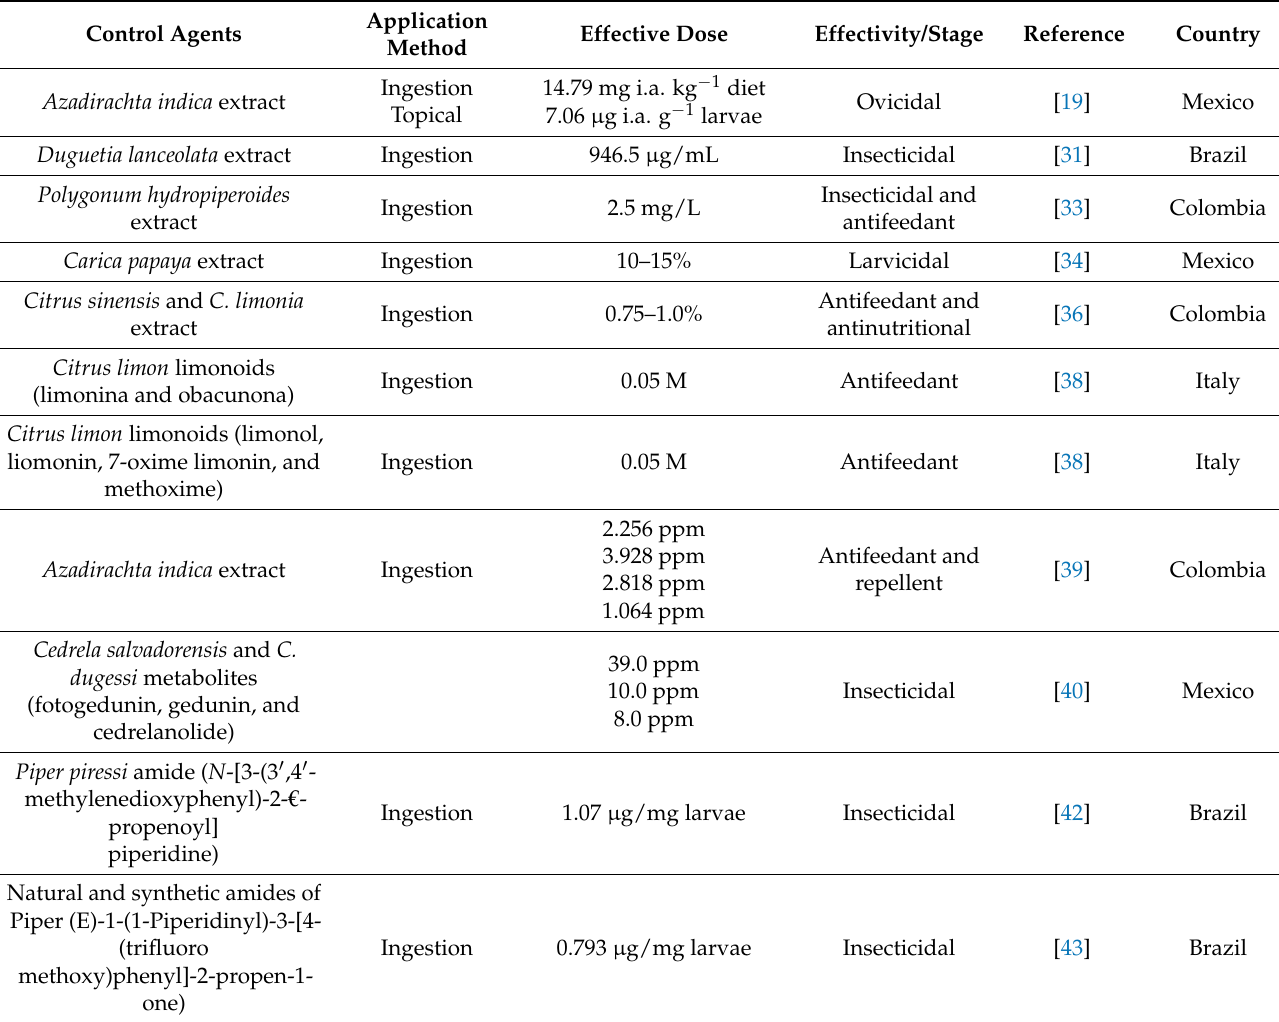
Figure 14. Structure of the active 2,4,5-trimethoxystyrene metabolite from Duguetia lanceolata. The insecticidal activity of common pesticidal plants was recently evaluated on a population of second instar larvae of S. frugiperda from Malawi, Africa. Ten extracts of the plants Azadirachta indica , Ocimum basilicum L., Nicotiana tabacum L., Cymbopogon citratus (DC.) Stapf., Tephrosia vogelii (Hook.f.), Aloe vera (L.) Burm.f., Lantana camara (L.), Trichilia emetica (Forssk.) Vahl, Vernonia amygdalina (Delile), and Lippia javanica (Burm.f.) Spreng were used. In the contact toxicity tests, the highest larval mortality was obtained from Nicotiana tabacum (66%) and Lippia javanica (66%) and by ingestion of L. javanica (62%) and N. tabacum (60%) at a concentration of 10% [44]. The characteristics of the biological evaluations are presented in Table 2. Table 2. Metabolites and extracts from plants with potential insecticidal activity against S. frugiperda